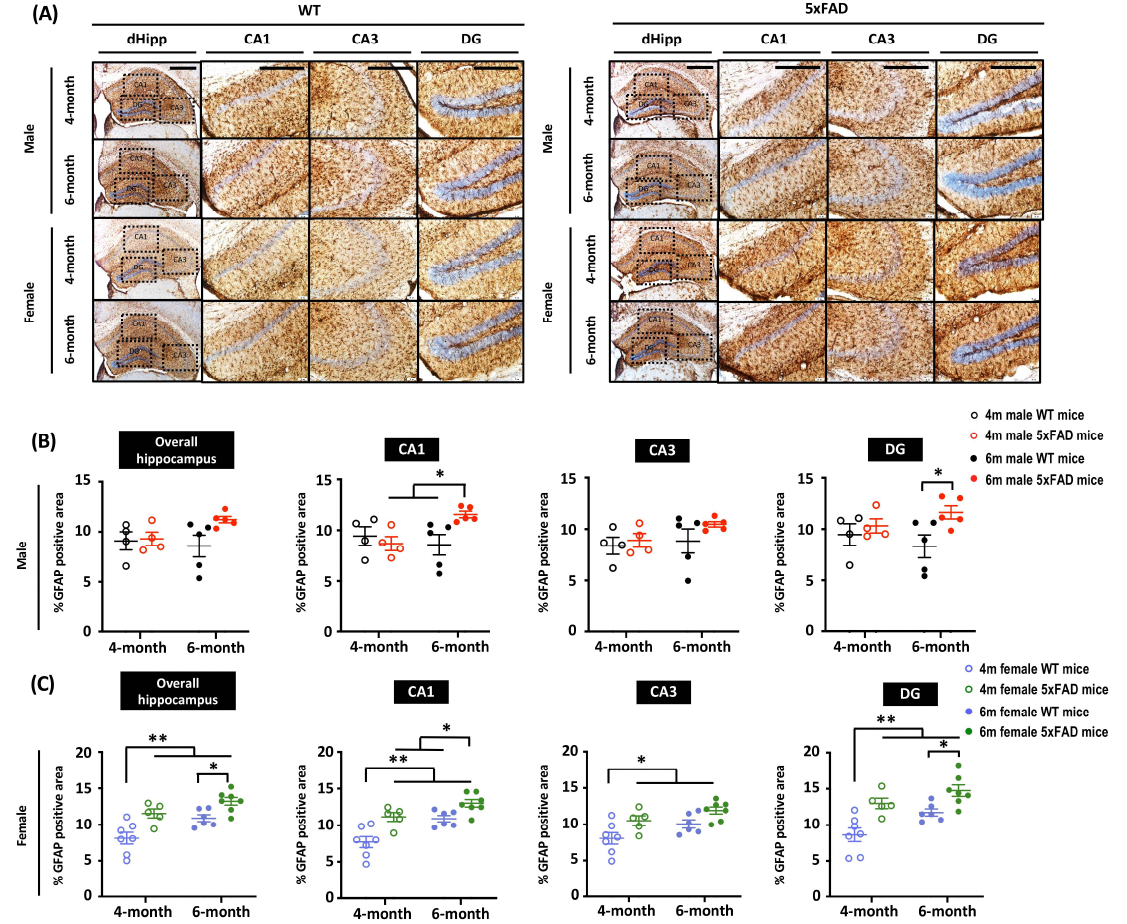
Figure 4. Enhanced astrogliosis was observed in 6-month-old female 5xFAD mice, but not in male 5xFAD mice. ( A ) Representative images of hippocampal sections stained with anti-GFAP antibody from 4- and 6-month-old mice. Scale bar: 200 μm. ( B ) Quantification of GFAP intensity in sections from male animals shows significant main effects of Age × Genotype (F (1, 14) = 5.605, p = 0.033) in